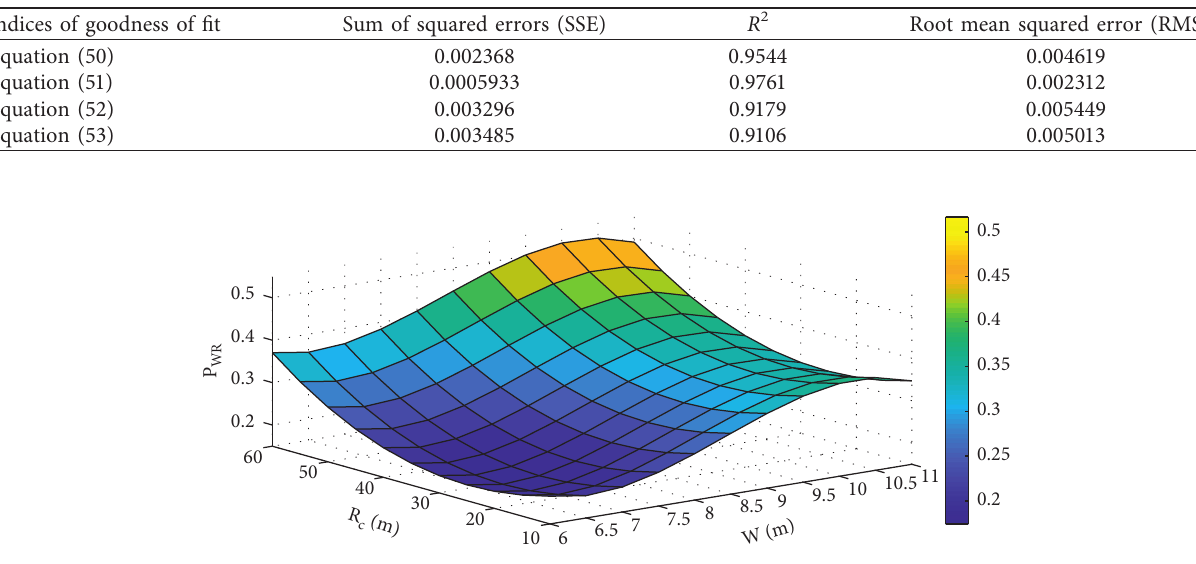
Figure 18: Curve of relationship among P